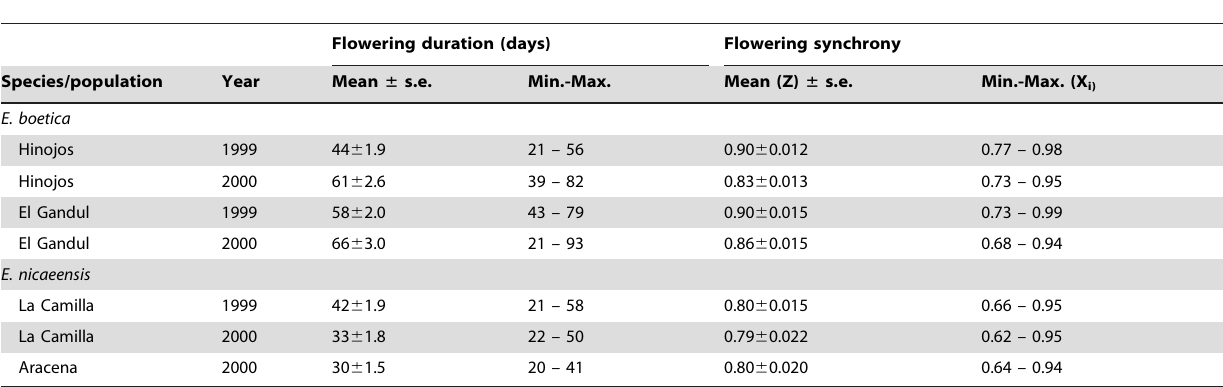
Table 1. Flowering duration and synchrony of Euphorbia boetica and E. nicaeensis plants during two years.